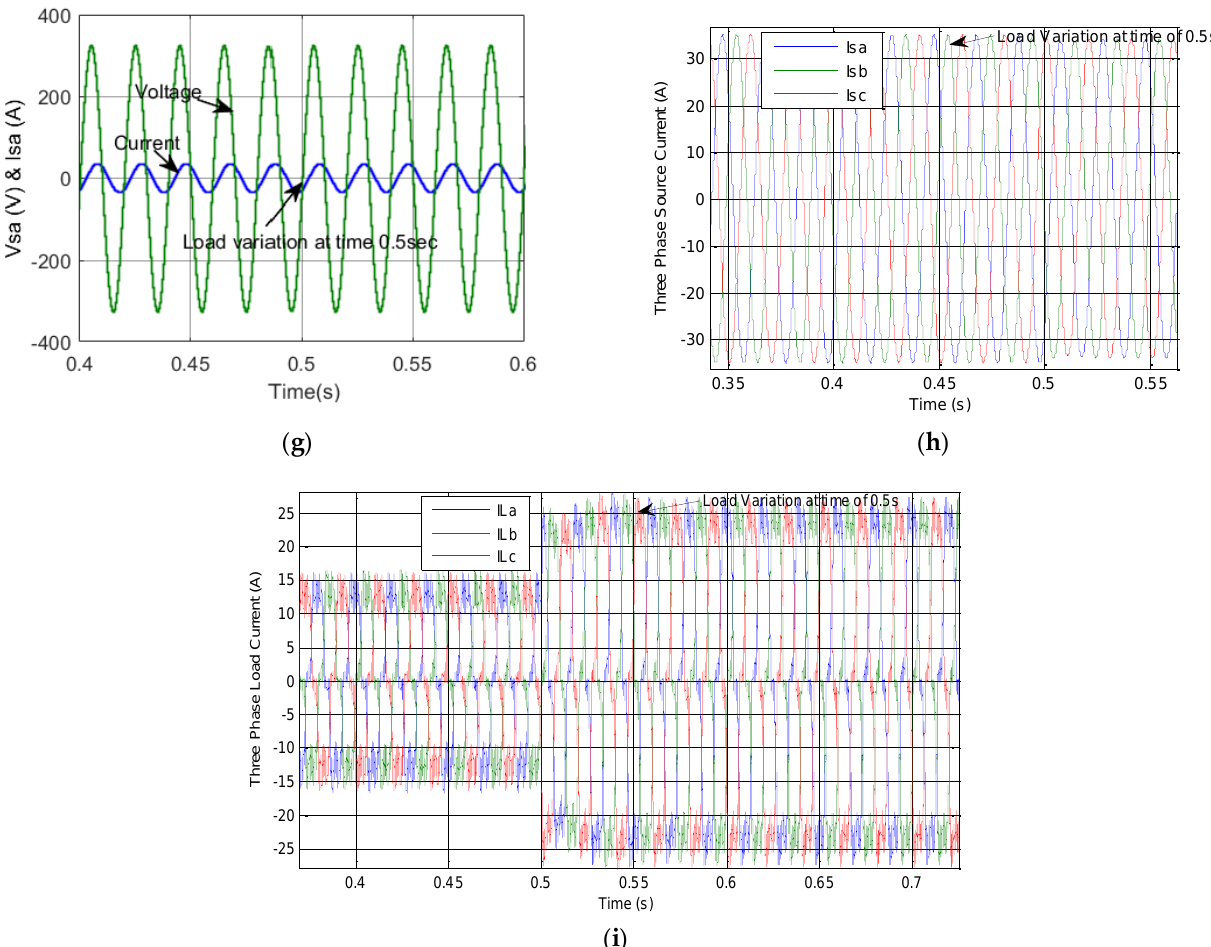
Figure 15. Simulated responses of three phase SSI-based SAPF connected at DRB RC load with SPWM and FLC controller, ( a ) Supply current, ( b ) load current, ( c ) compensation current, ( d ) THD, ( e ) V 2 DC links voltage, ( f ) SSI output voltage, ( g ) source voltage (V sa ) and source current (I sa ) of phase A, ( h ) zoomed source current and ( i ) zoomed load current.